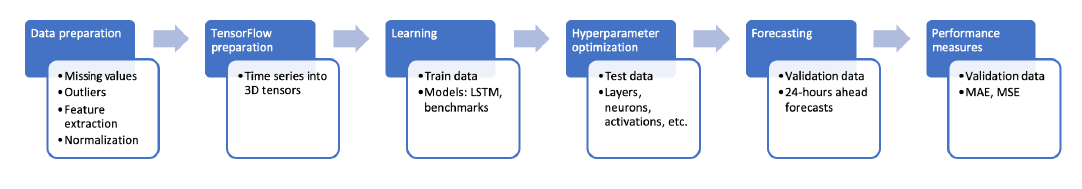
Figure 10. Proposed methodology (flow